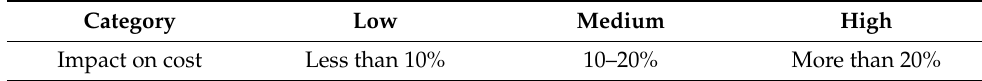
Table 5. The Classifications of outputs.